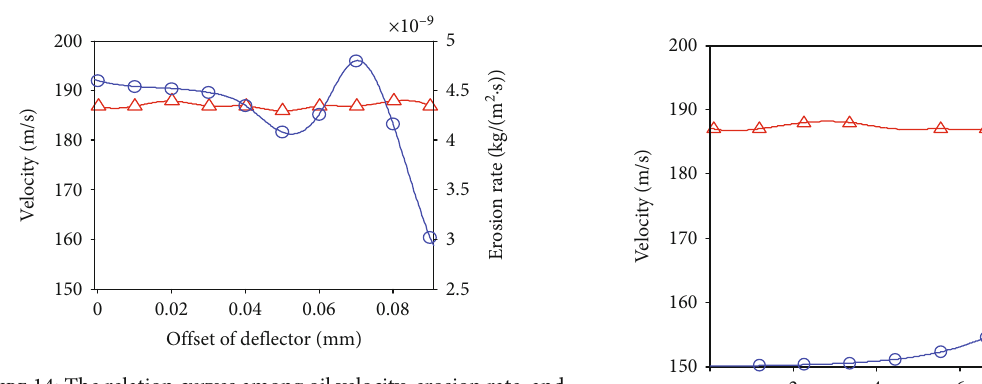
Figure 14: The relation curves among oil velocity, erosion rate, and de fl ector ’ s o ff set.